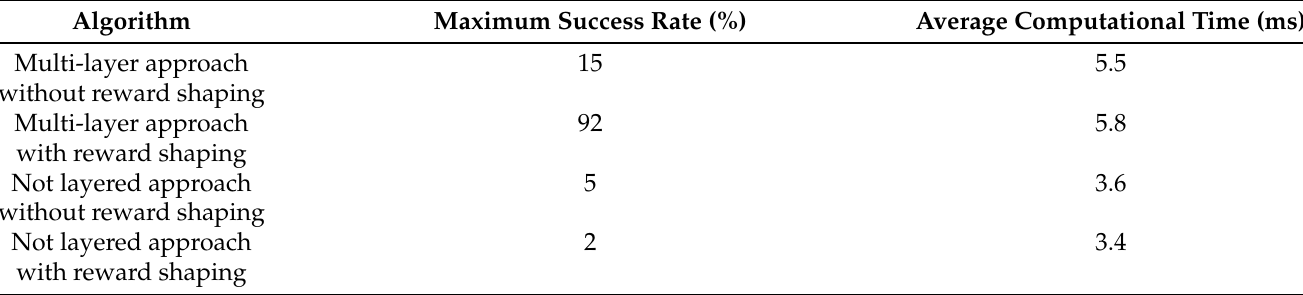
Table 5. Simulation results of algorithm considering arrival